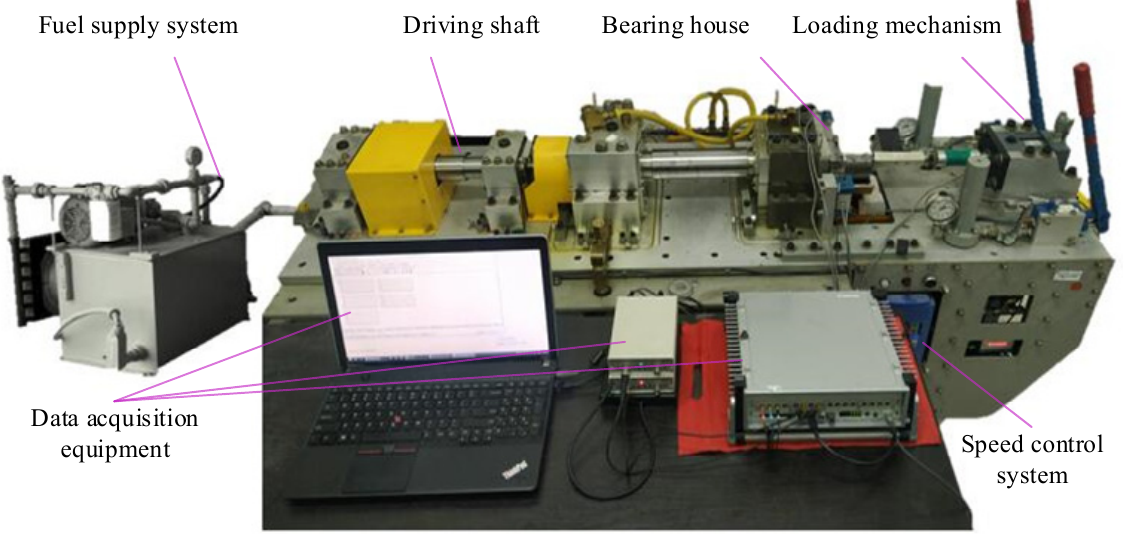
Figure 8. Bearing prognostics simulator.